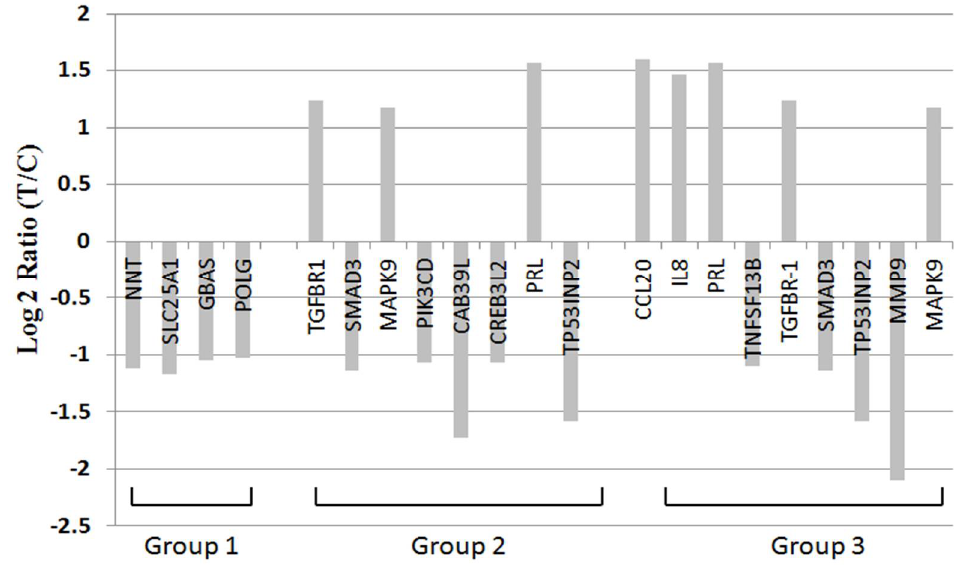
Figure 5. RNA microarray analysis of BDH2 targeting genes. Group 1: genes related to mitochondria; group 2: genes that have been reported as oncogenes or tumor suppressor genes; group 3: genes that function to control the survival, growth, differentiation, proliferation, and effector function of tissues and cells. All of those genes showed statistical significance with p < 0.05.